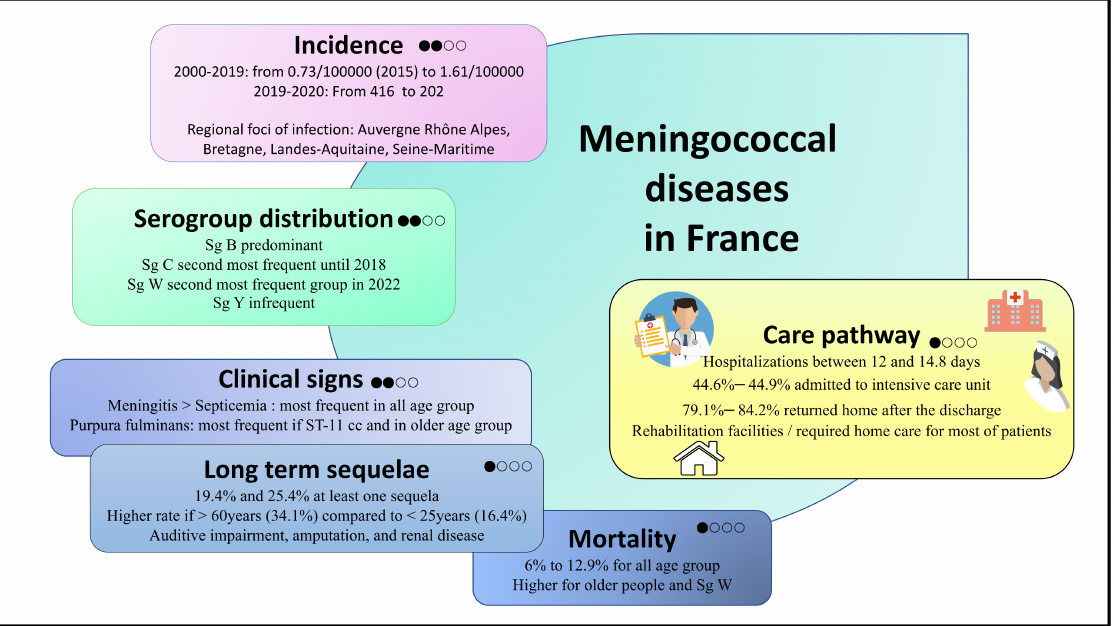
Figure 2. Summary of the results based on the GRADE process. High, when the true effect lies close to that of the estimate of the effect; moderate, when the true effect is likely to be close to the estimated effect, but there is a possibility that is substantially different; low, when true effect may be substantially different from the estimated effect; and very low, when the true effect is likely to be substantially different from the estimated effect. Sg: Serogroup; cc: clonal